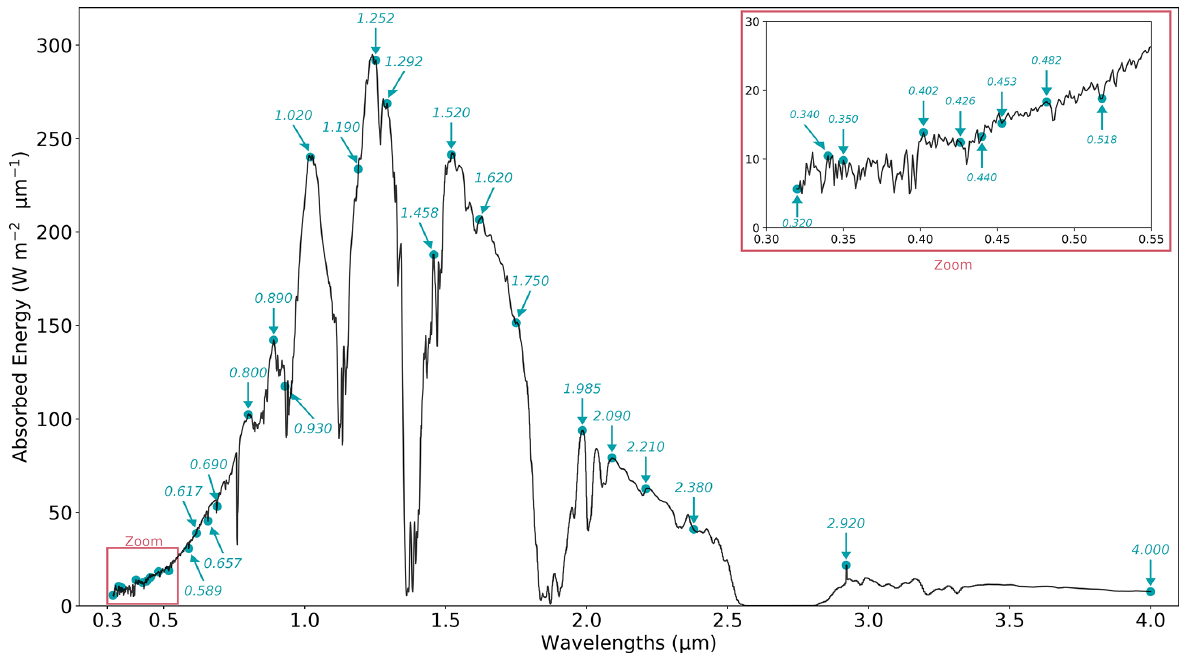
Figure 1. Spectral positions of TPs on an example of an absorbed energy profile for a snowpack without